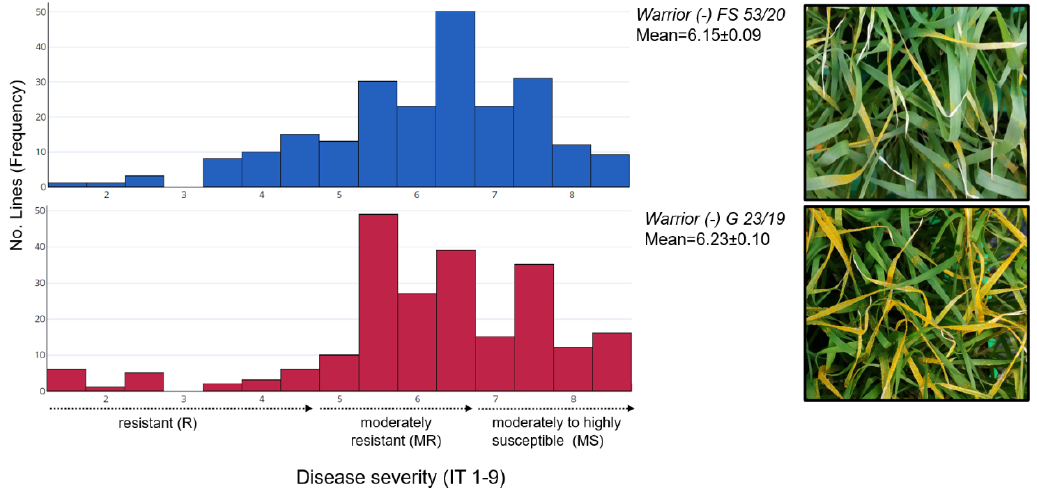
Figure 1. Frequency distribution of yellow rust disease severity (based on infection type) for associ- ation panel evaluated with Pst pathotypes Warrior (-) FS 53/20 and Warrior (-) G 23/19 . Typical uredinia of yellow rust caused by each Pst pathotype are shown on the right.